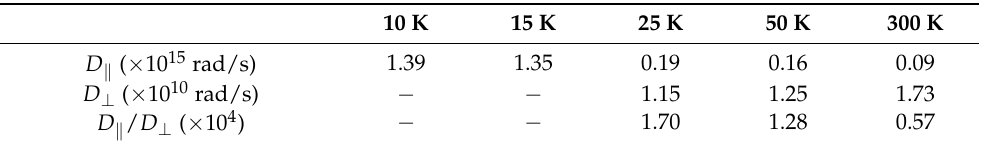
Table 1. The diffusion rates for regio-regular P3HT–ZnO nanoparticles at several temperatures without light irradiation obtained in this study.